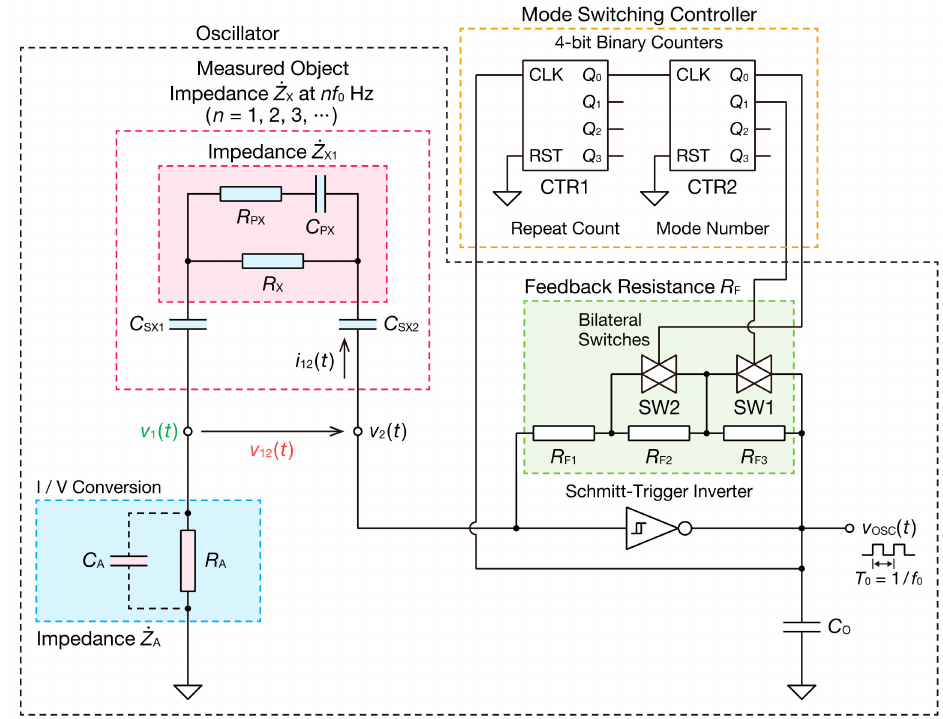
Figure 1. Mode-switching nonsinusoidal oscillator. The oscillation frequency f 0 and the oscillation period T 0 of the oscillator are switched between four different frequencies by 4-bit binary counters and bilateral analog switches. CLK of 4-bit binary counters denotes a clock signal, and RST represents a reset signal. Q 0 , Q 1 , Q 2, and Q 3 of 4-bit binary counters denote zero bits, and the first, second, and third bits of the output signals, respectively. C O represents a bypass capacitor to remove the switching noise in the oscillator, and its value is 0.47 nF. CTR1 and CTR2 are binary counters to control the repeat count and the mode number of the mode switching, respectively.